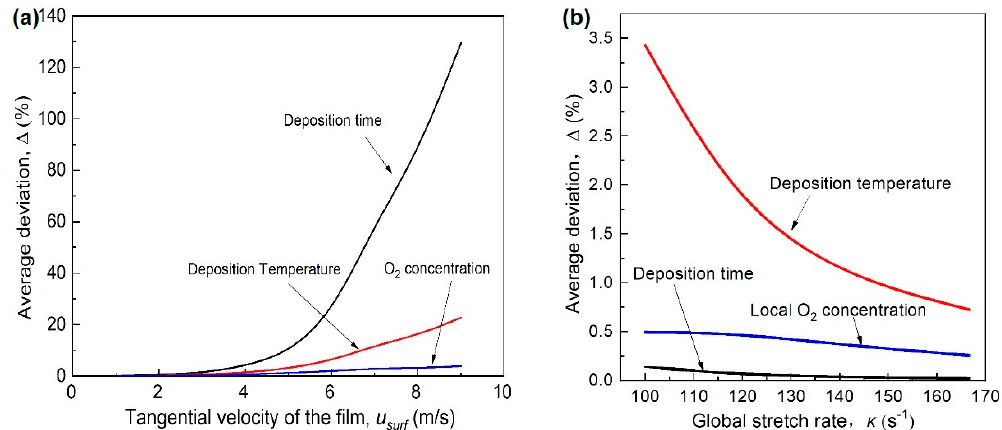
Figure 13. The effects of ( a ) tangential velocity and ( b ) stretch rate on the nanoparticle deposition. The flame stretch is a dominant factor to the flow and temperature fields for the stagnation